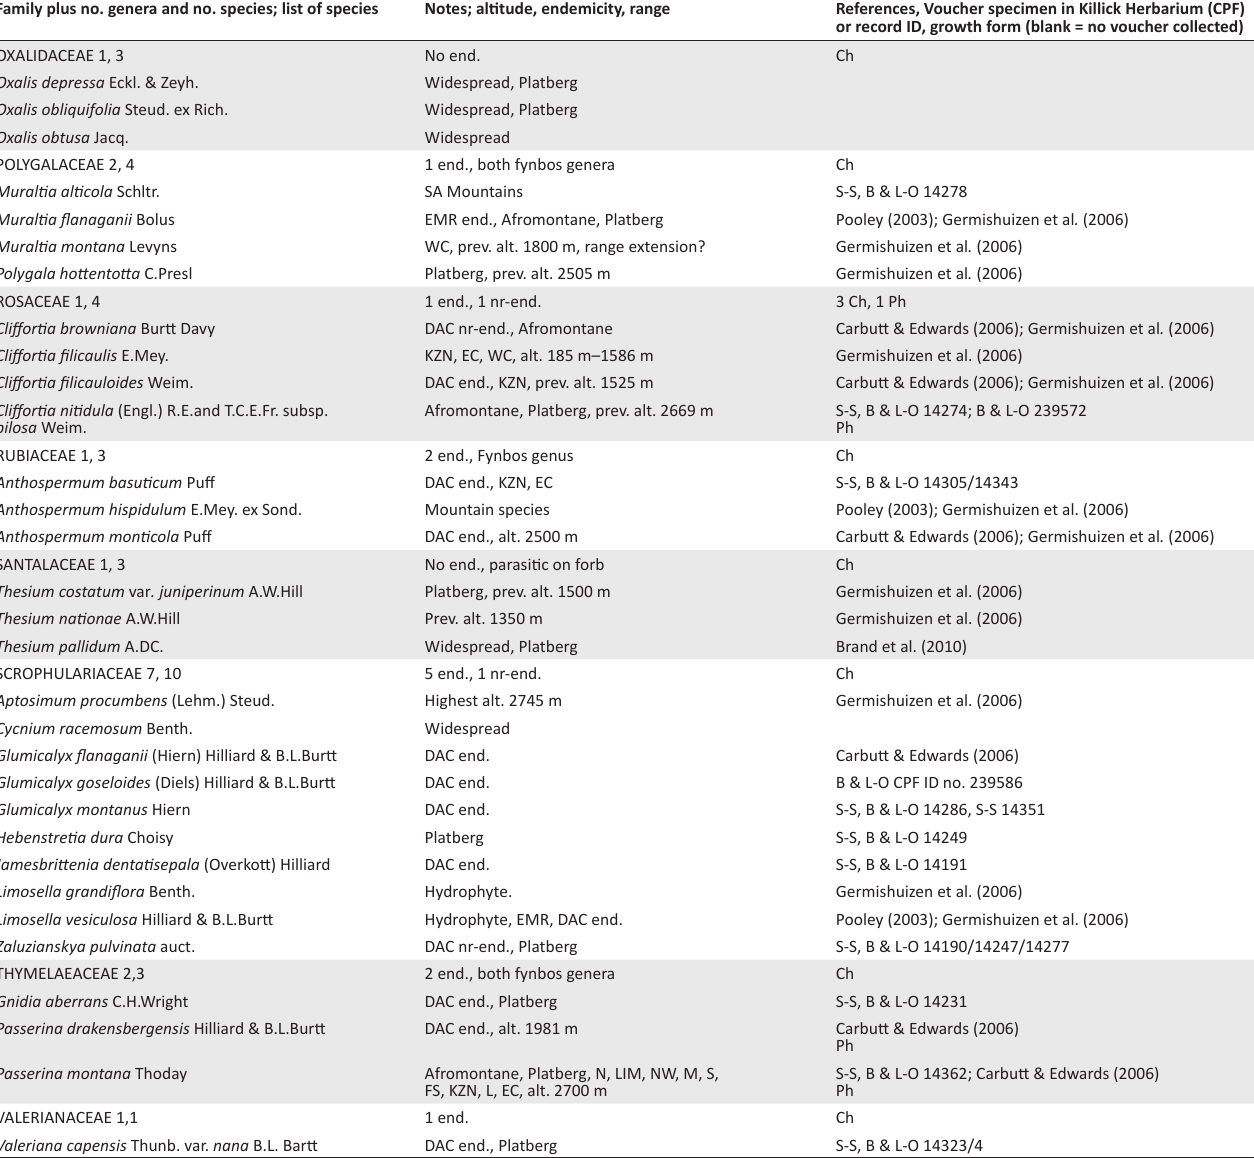
TABLE 2-A1: Angiosperms – Monocotyledons, 16 Families, 37 Genera, 66 Species, 13 endemics, 25 near endemics = 38. Family plus no. genera and no. species; list of species Notes; altitude, endemicity,